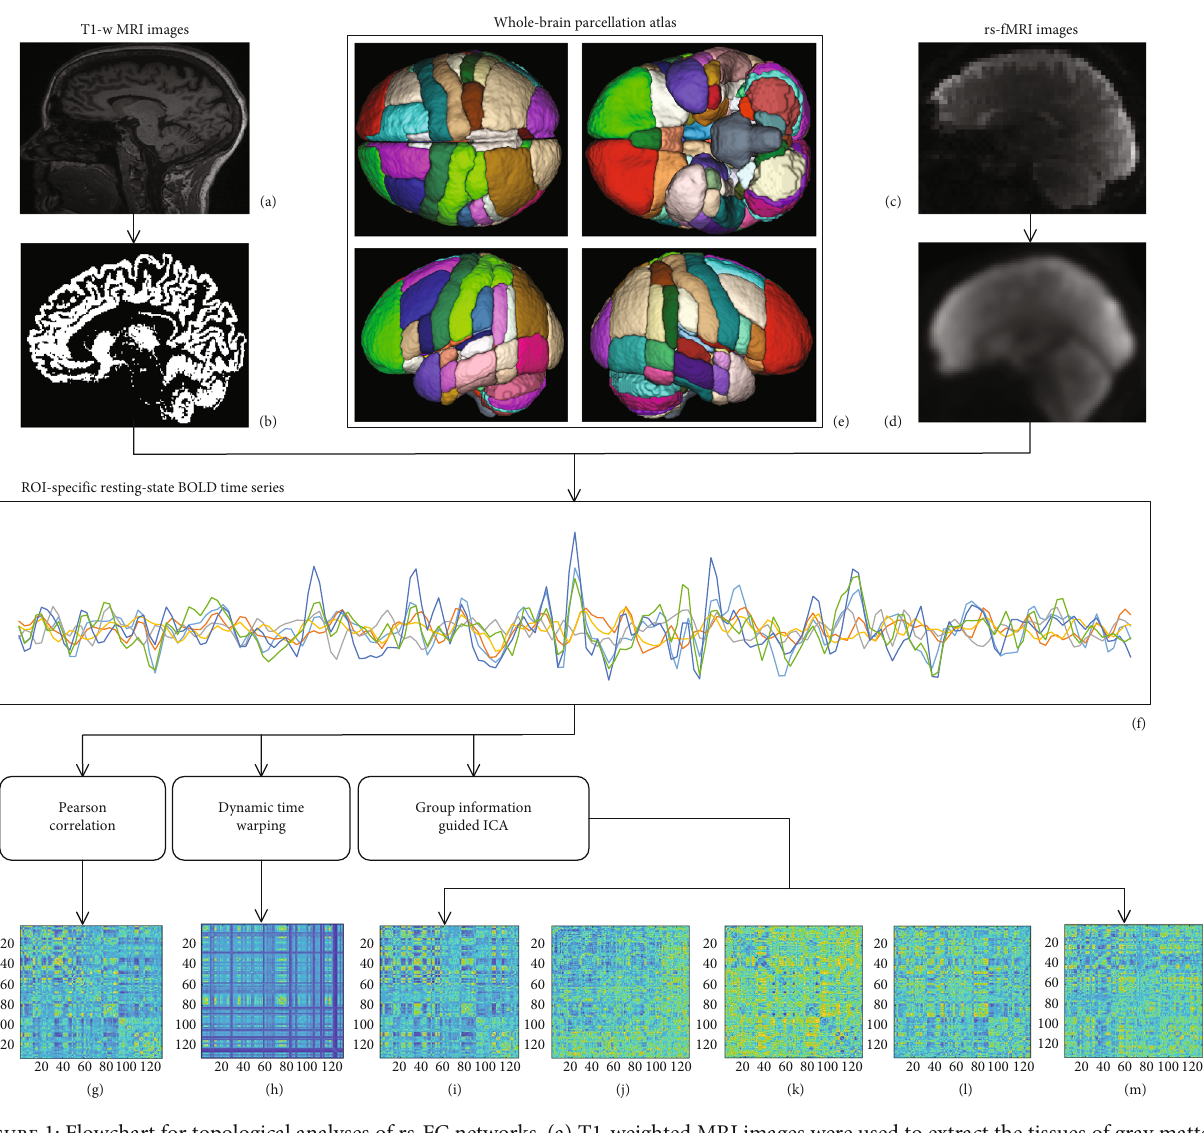
Figure 1: Flowchart for topological analyses of rs-FC networks. (a) T1-weighted MRI images were used to extract the tissues of gray matter, white matter, and cerebrospinal fl uid. (b) Gray matter was coregistered into MNI space. (c) Original fMRI images were smoothed and coregistered into (d) MNI space. (e) Whole-brain parcellation atlas in MNI space was used to parcellate whole-brain into 132 parcels (Table 2), including cerebrum and cerebellum. (f) ROI-speci fi c time serial was obtained by averaging BOLD signal timeseries within ROI voxels. (g) FC adjacent matrix computed with Pearson correlation. (h) FC adjacent matrix estimated with DTW. (i – m) Five ICA components extracted with